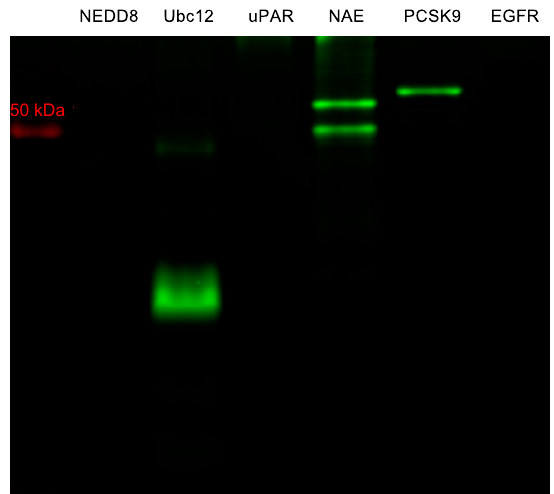
Figure 6. NIR fluorescent gel image of diverse proteins (4 µM) incubated with MHI-148 (4 µM) for 3 h using 50 mM pH 7.24 HEPES buffer at 37 °C.